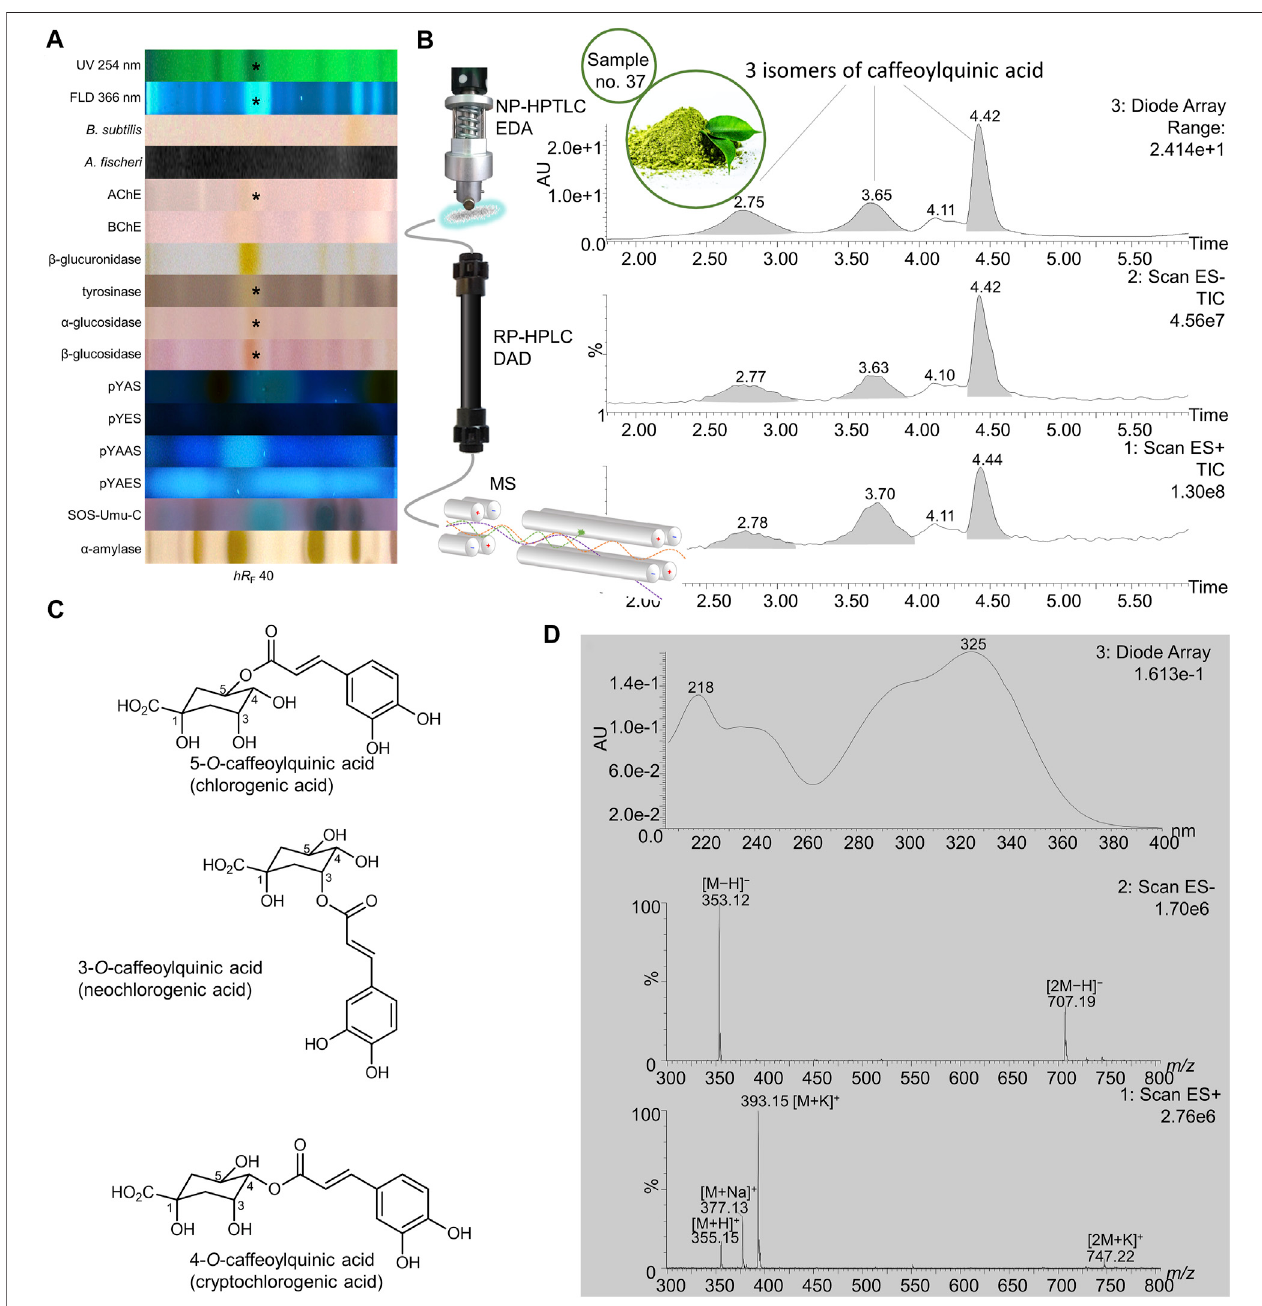
FIGURE10 | NP-HPTLC − UV/Vis/FLD − EDA − heart-cut RP-HPLC − DAD − HESI-MS analysis ofyerba mate green no. 37. NP-HPTLC − UV/Vis/FLD − EDAanalysisas in Figure 3 (A) , followed by heart-cut elution of the bioactive zone at hR F 40 (marked*) directly out of the BChE autogram and online desalting to obtain the RP- HPLC − DAD − HESI-MS chromatograms (B) and respective UV and mass spectra for the peaks at RT 2.78, 3.70, and 4.44 min, which were assigned to the isomeric structures of caffeoylquinic acid with the most predominant depicted, (C) as all three peaks provided the same signals (D) .